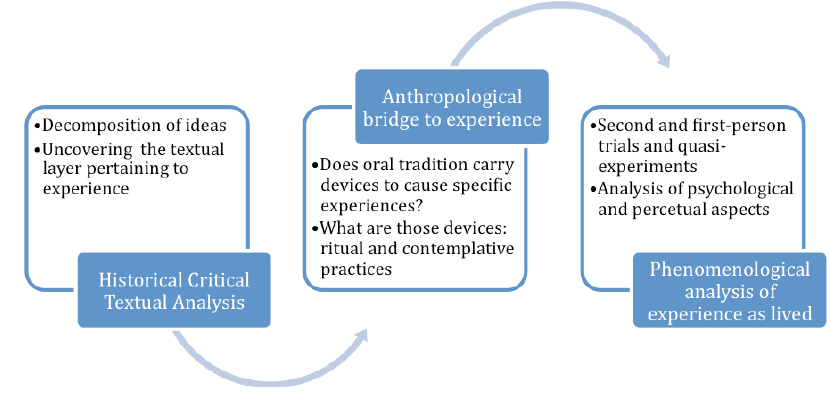
Figure 1. Stages of analysis of Theophanis’